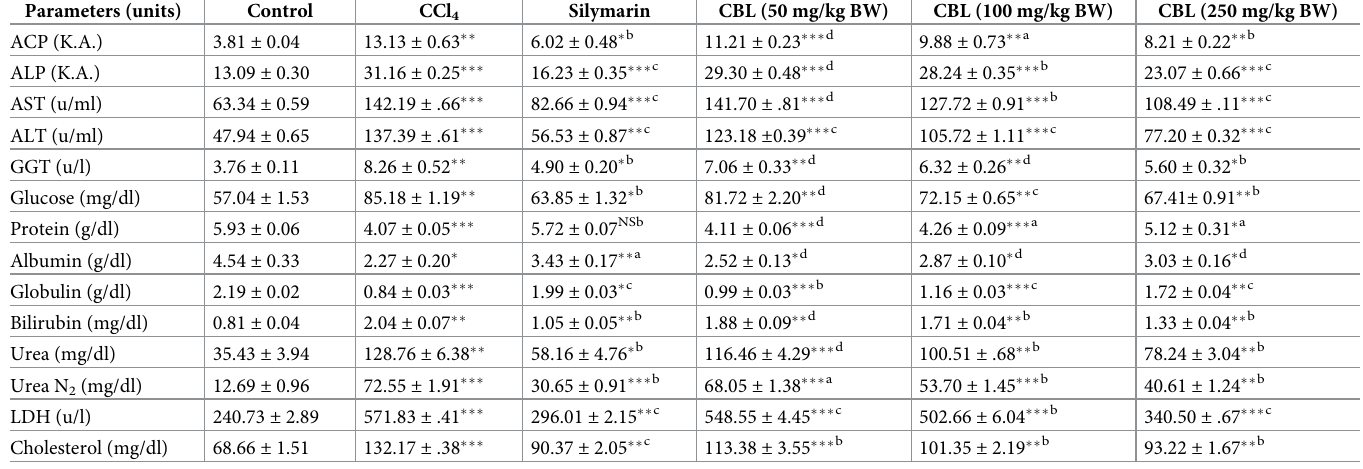
Table 2. Describes the levels of various enzymatic and biochemical parameters in the serum of six (n = 6) treated groups. The data represented as mean ± SD of six observations. Parameters